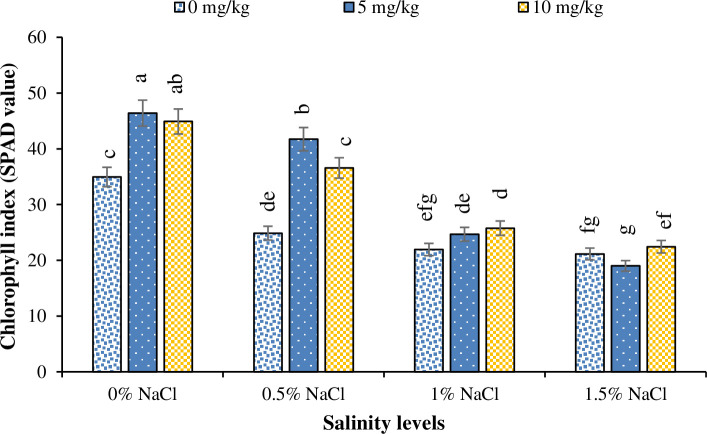
The influence of different Zinc (Zn) levels on chlorophyll index of Basil (Ocimum basilicum L.) grown under different NaCl salinity levels.The vertical bars are means ± standard errors. Any two means having different letters are statistically different from each other (p < 0.05).